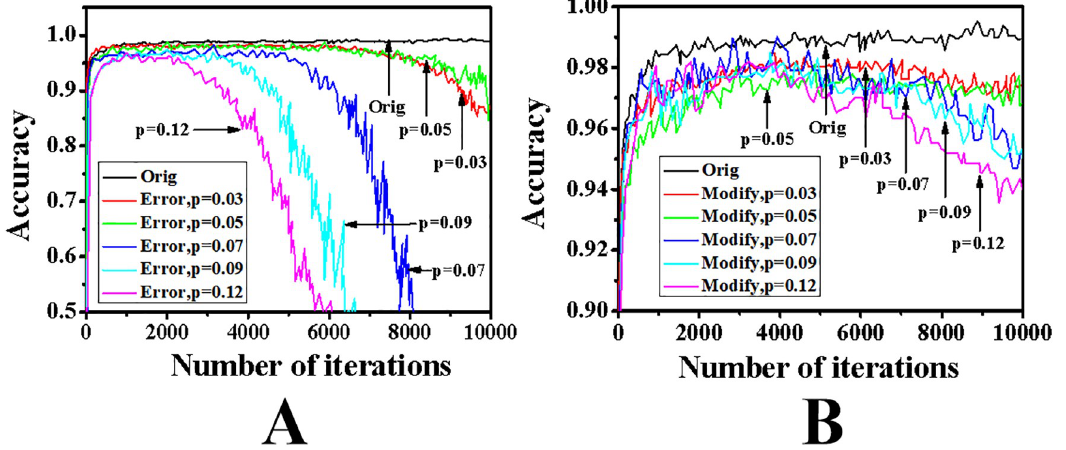
Fig 8. The influence of label modification on the prediction accuracy of MS-CNN model (A is the change of the final prediction accuracy value of the model in this study; B is the change in the final prediction accuracy value when the label is wrong).